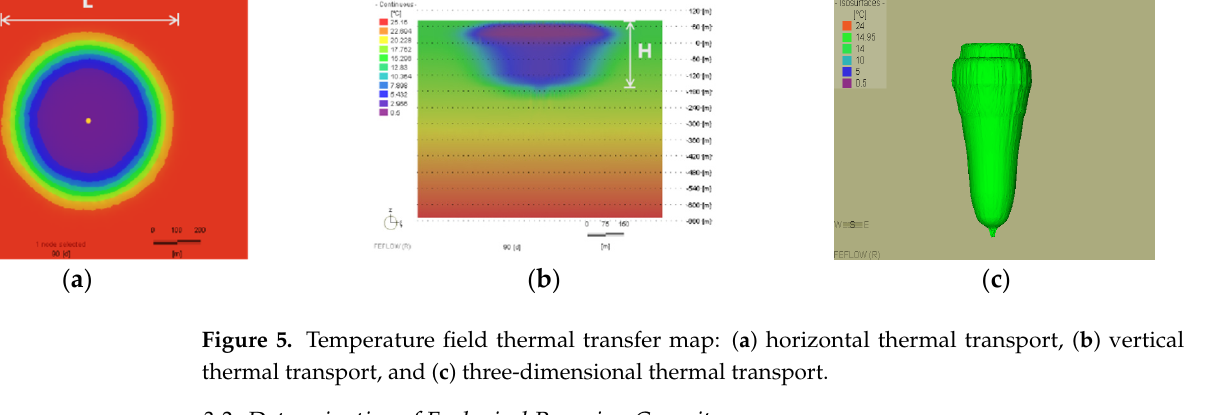
Table 3. Pumping capacity conditions of different factors.